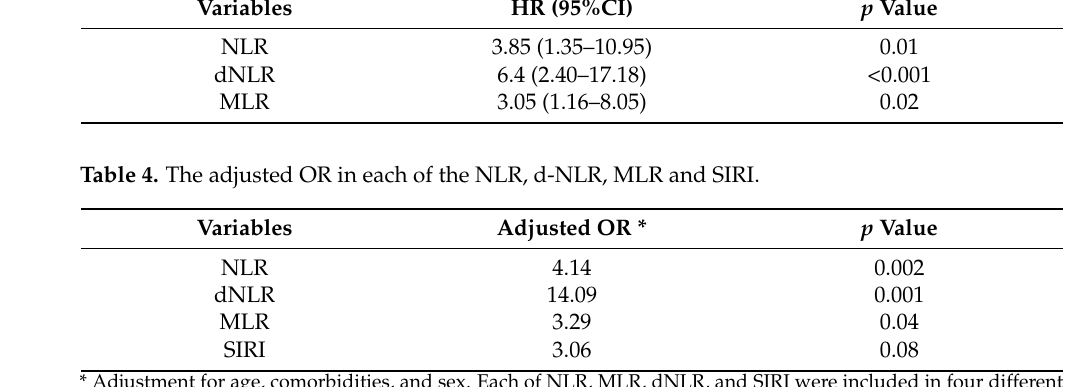
Figure 3. Kaplan–Meier survival curves of hospitalized COVID-19 patients: ( a ) according to estab- lished MLR cutoff values; ( b ) according to established SIRI cutoff values. Furthermore, univariate Cox regression analysis showed that NLR, dNLR, and MLR were independent predictors of in-hospital mortality (Table 3). Table 3. Hazard ratios of the indexes obtained by univariate Cox regression analysis. Variables